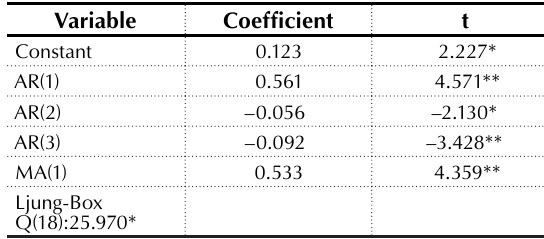
Table 4. Result of ARIMA